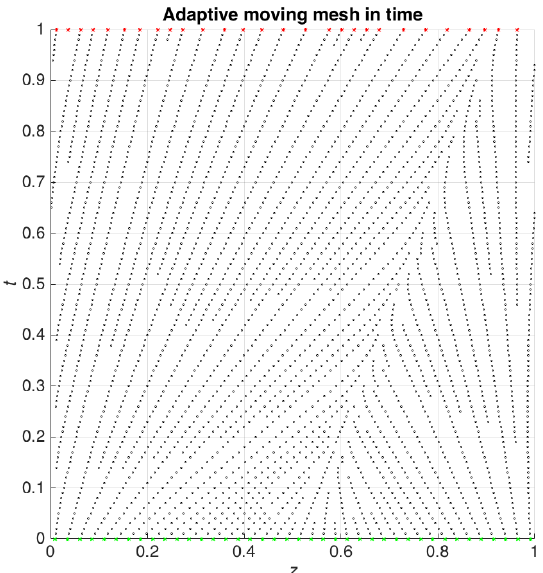
Figure 2. An illustration of adaptive moving mesh over time solving Burgers’ equation (see Sect. 6) until t = 1 on a domain z = [ 0 , 1 ) . In this example, the remeshing criteria are based on δ 1 = 0 . 02 and δ 2 = 0 . 05. There are 40 initial adaptive moving mesh nodes and 27 nodes at t = 1; these are shown in green and red,